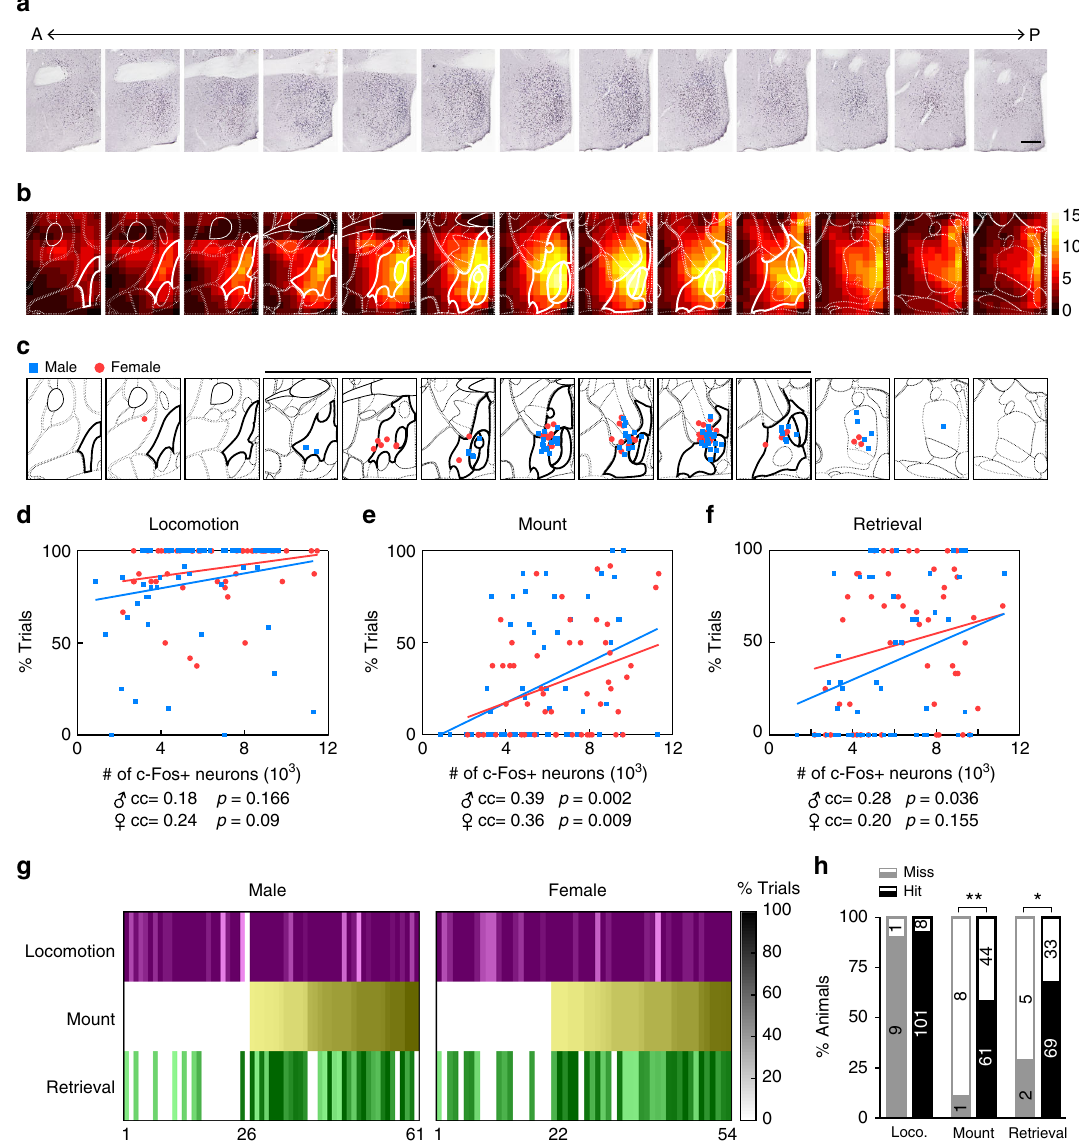
Fig. 4 Correlation between optogenetically induced c-Fos expression and behaviors. a Example images of DAB staining of light-induced c-Fos expression in a ChR2 animal along the anterior – posterior axis at ~80 μ m intervals. Scale bar, 200 μ m. b Heat map representation of light-induced c-Fos expression averaged across animals. Brie fl y, c-Fos signals within each 100 μ m 2 square in a 1100 × 1500 μ m area as in a were counted, tallied, averaged, plotted, and projected onto a reference atlas (http://www.brain-map.org/, image 49 – 61). White bold lines highlight the mPOA de fi ned by the atlas. Scale shown on the right. c Activation centers for ChR2 animals. N = 66 males and 53 females. d – f Correlation between total number of c-Fos signals in sections highlighted with the thick black line in c and the trial occurrence of light-induced locomotion ( d ), mount ( e ), and pup retrieval ( f ) for both male and female ChR2 animals. Pearson ’ s correlation. g Distribution of optogenetic-induced locomotion, mount, and pup retrieval (color coded) in ChR2 males (left) and females (right) with each column corresponding to a ChR2 animal and the shade of each cell corresponding to the trial occurrence of the behavior indicated on the left. The scale bar is on the right. Animals were sorted according to the occurrence of light-induced mounting behavior. Out of 35 males and 33 females that displayed light-induced mounting, 31 males and 31 females also displayed light-induced pup retrieval. Of 26 males and 22 females that did not display light-induced mounting, only 8 males and 10 females displayed light-induced pup retrieval. h Categorical comparison of the occurrence of light-induced locomotion, mount, and pup retrieval at the animal level between groups whose activation center lie within or close to the mPOA, as in sections highlighted with a black line in c (hit), and those away from the mPOA (miss). Filled segments indicate the fraction of animals in each group that displayed optogenetically induced behaviors listed below while corresponding empty segments indicate the fraction that did not display the behavior. Fisher ’ s exact test. * p < 0.05, ** p = remained female biased and was comparable between ChR2 and optogenetically induced retrieval persisted under lowered power control animals (Fig. 3l). Together, these results show that of stimulation or after castration (Fig. 3j – k). By contrast, spon- optogenetic stimulation of the mPOA elicits similar pup retrieval taneous pup retrieval behavior outside of photostimulation behavior in both males and females despite female-biased display